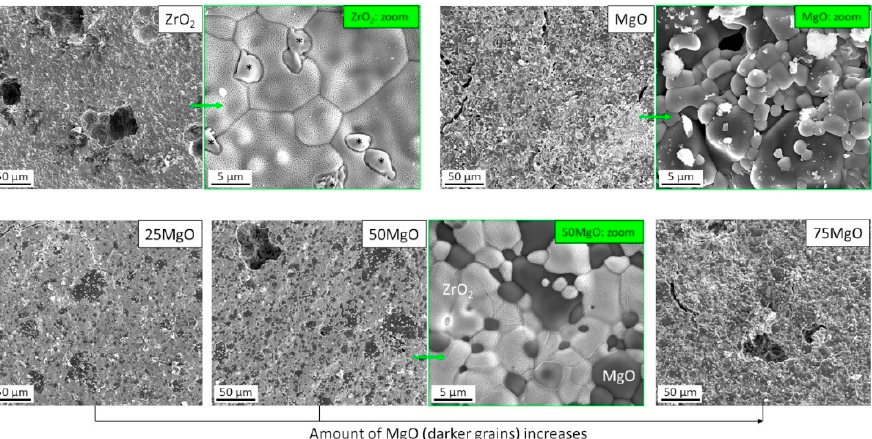
Figure 1. SEM micrographs of pure ( top ) and mixed ( bottom ) ZrO 2 /MgO ceramics. Lighter (ZrO 2 ) and darker (MgO) grains are well visible. Additional formations (*) in pure ZrO 2 are probably the tetragonal t-ZrO 2 phase (see text).